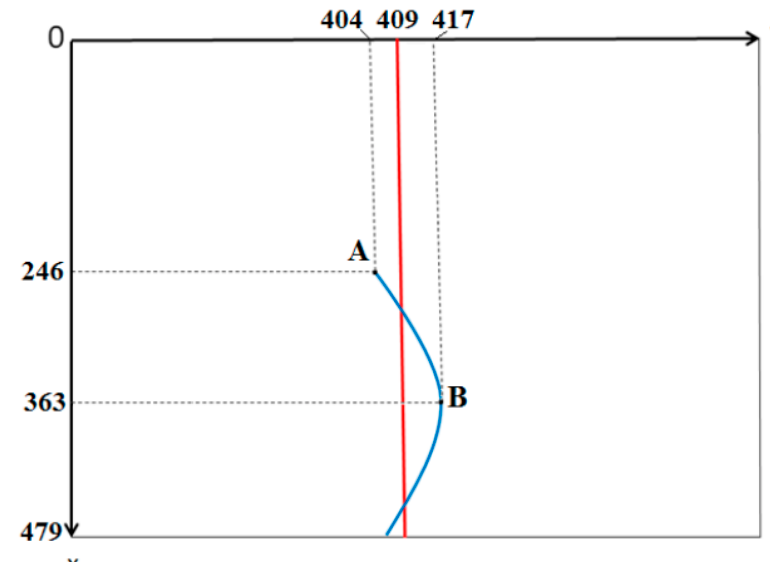
Figure 3. Determined vehicle position at points A and B, in the x and y system, expressed by the number of pixels on the screen (after conversion to numerical data).